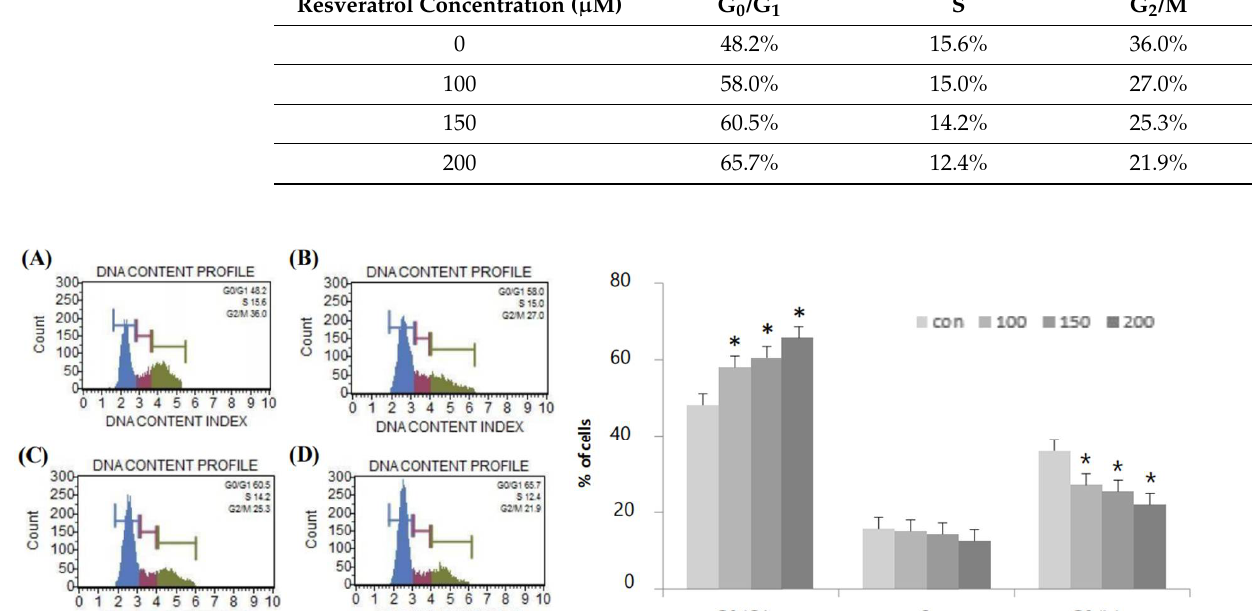
Table 1. Percentages of cells in G 0 /G 1 , S, and G 2 /M phases.